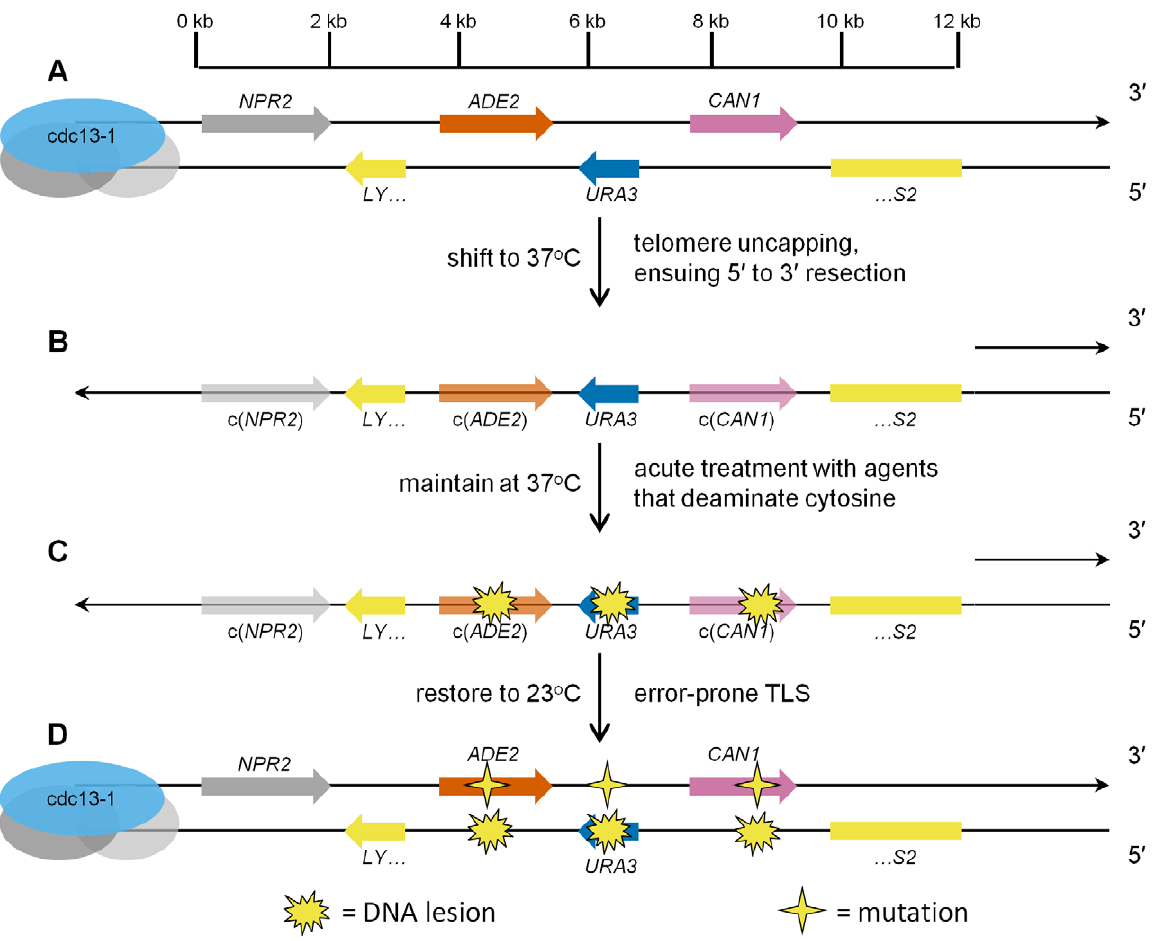
Figure 1. Schematic representation of ssDNA mutagenesis reporter system. (A) Three reporter genes, ADE2 , URA3 , and CAN1 , were relocated from their respective native genomic loci into the subtelomeric region of Chromosome V, within a haploid budding yeast strain bearing the temperature-sensitive cdc13-1 mutation, thus creating strain ySR127. The 0 kb mark in the scale bar denotes the start of unique DNA sequence (conversely, the end of telomeric repeat sequences). (B) Shifting ySR127 cells to 37 u C results in telomere uncapping. Subsequent 5 9 to 3 9 resection results in a long 3 9 ssDNA overhang. c( ADE2 ) and c( CAN1 ) denote the complement of the two genes. (C) Cells then undergo acute treatment with agents that deaminate cytosine, e.g. human APOBEC3G or sodium bisulfite, which induce lesions in the 3 9 ssDNA overhang. (D) Shifting back to permissive temperature (23 u C) restores the subtelomeric DNA to double-stranded form. Error-prone bypass of lesions formed in ssDNA generates a strand-coordinated, multi-mutation signature, which is detected by simultaneous loss of function in two or more of the reporter genes, and verified by sequencing of individual multi-loss-of-function isolates.